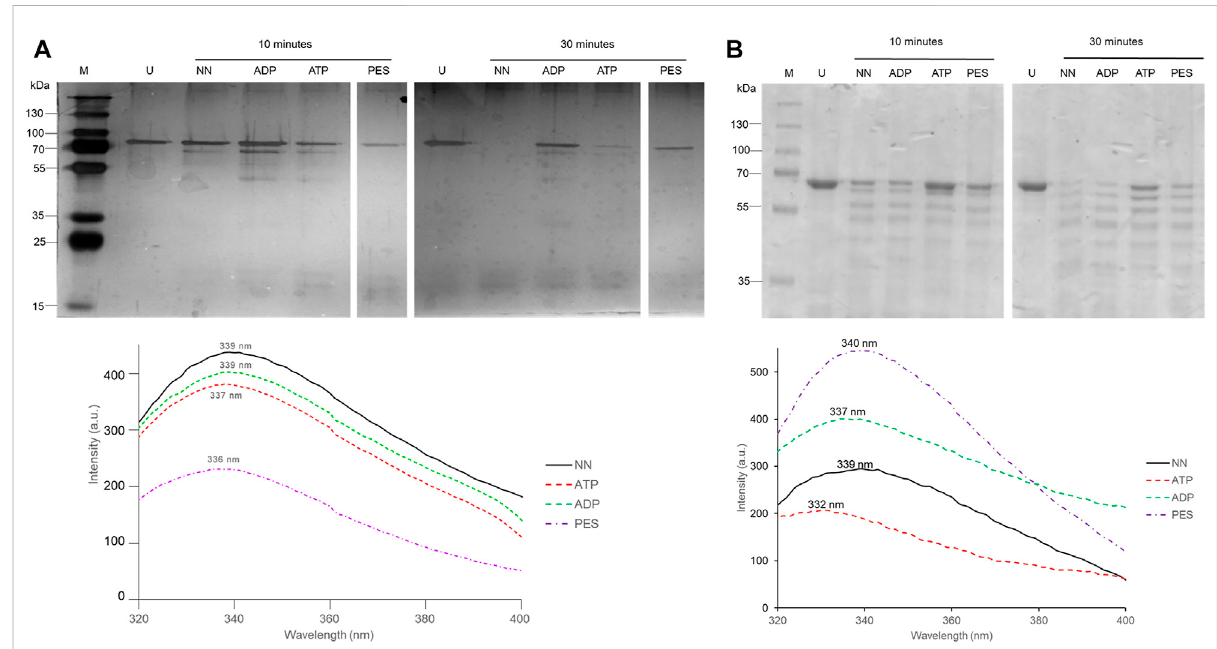
FIGURE 5 PES induces conformational changes in PfHsp70-1. Recombinant PfHsp70-1 (A) protein was subjected to limited proteolysis (top panel) and intrinsic fl uorescence analysis (lower panel) in the presence of ATP/ADP and PES. Similarly, recombinant PfHop protein (B) was subjected to limited proteolysis (top panel) and intrinsic fl uorescence analysis (lower panel) in the presence of ATP/ADP and PES. Fluorescence emission spectra were averaged for seven spectral scans monitored at 310 – 400 nm after an initial excitation of 295 nm.